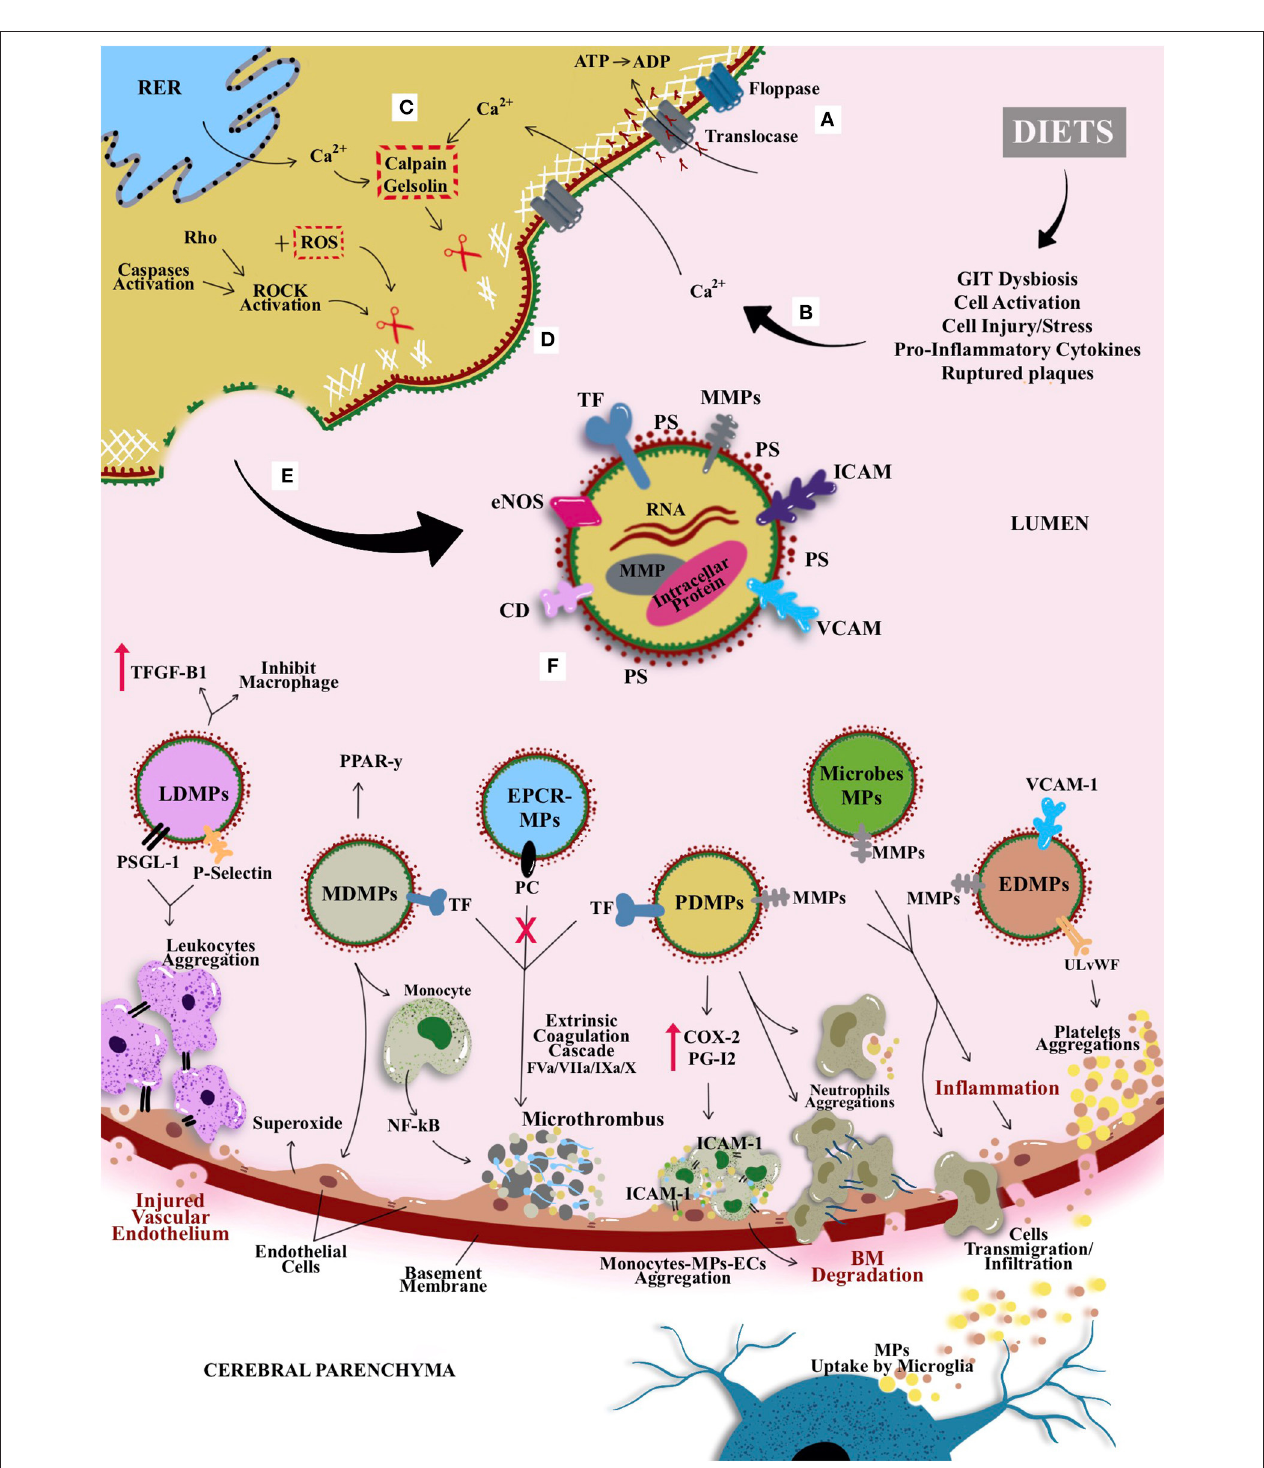
FIGURE 4 | The general mechanism of MP formation, its mode of action, and the proposed possible impacts of diets on MPs that could be linked with CSVD. (A) Active translocase transporting phosphatidylserine (PS) from outside to inside layer through adenosine triphosphate (ATP)–dependent manner. (B) Modifiable cardiocerebrovascular risk factors (with emphasis on dietary patterns in this review) are known to induce cellular activation or other cellular stressors (e.g., increased cytokines and from peripheral and GIT dysbiosis). (C) The activation causes an increase in intracellular cytosolic calcium release by stressed rough endoplasmic reticulum (RER) and acquired from extracellular space. Hence, activates enzymes calpain and gelsolin that cleave cell membrane cytoskeleton. (D) The cleaved cytoskeleton causes inactivation of translocase and hence induces phospholipid “flip-flopping.” (E) Externalization of PS produces MPs that bring their parent surface